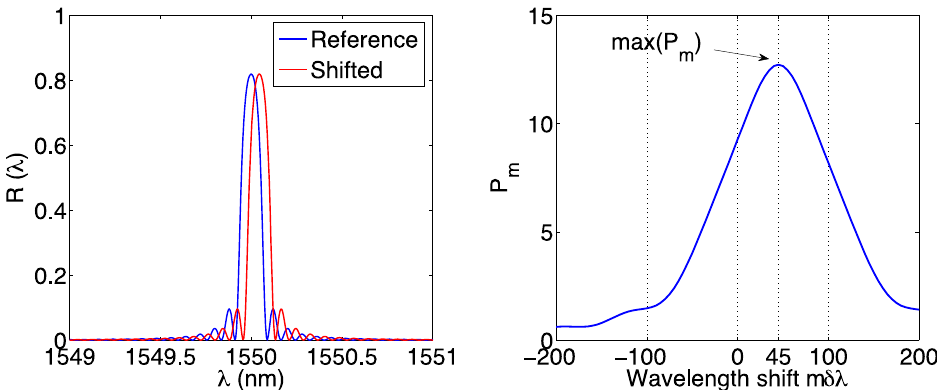
Figure 10. Sketch of the mutual correlation based peak tracking with wavelength shifting. ( Left ) reference and shifted spectra simulated over the wavelength resolution δλ = 5 pm; the shifted spectrum has 45 pm wavelength shift. ( Right ) the mutual correlation P m is calculated over all the wavelength shift values, identifying the wavelength shift as the value that maximizes P m : this coincides with the wavelength shift.